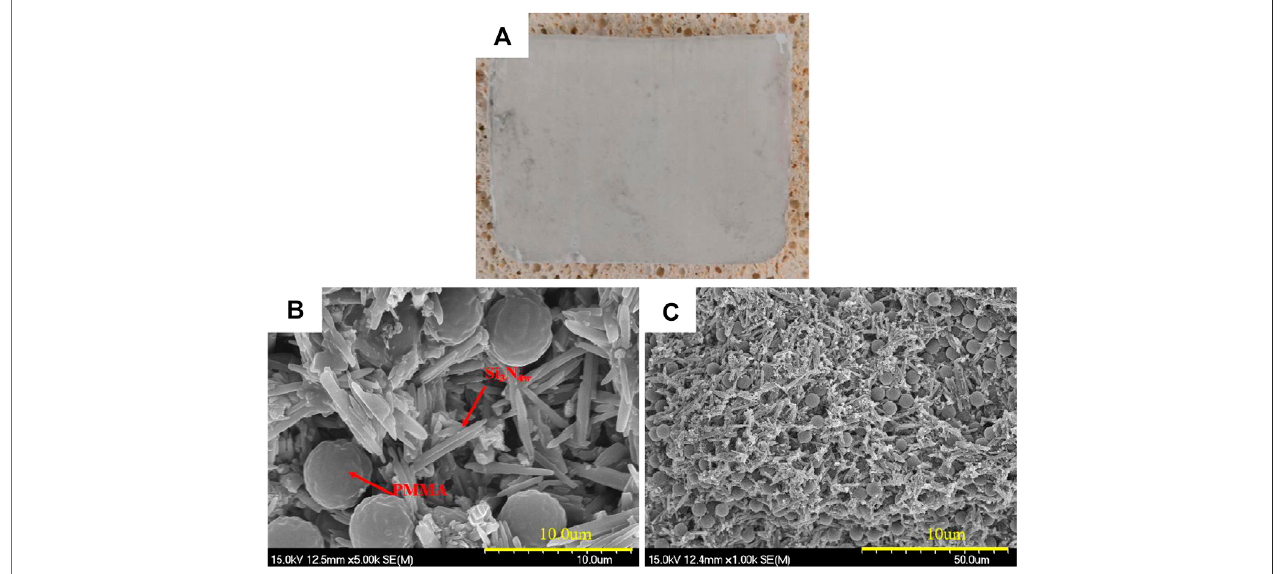
FIGURE 1 | Morphology of the Si 3 N 4w preform before decarbonization: (A) macro photo; (B) high magni fi cation SEM photo of section; (C) low magni fi cation SEM photo of section.